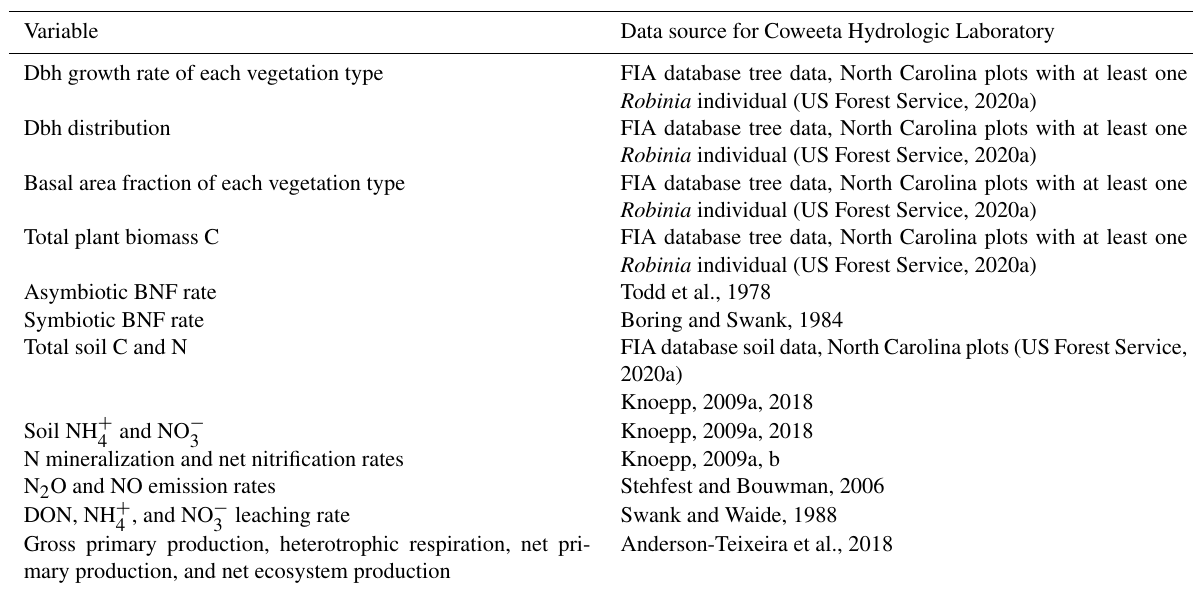
Table D5. Validated variables and data